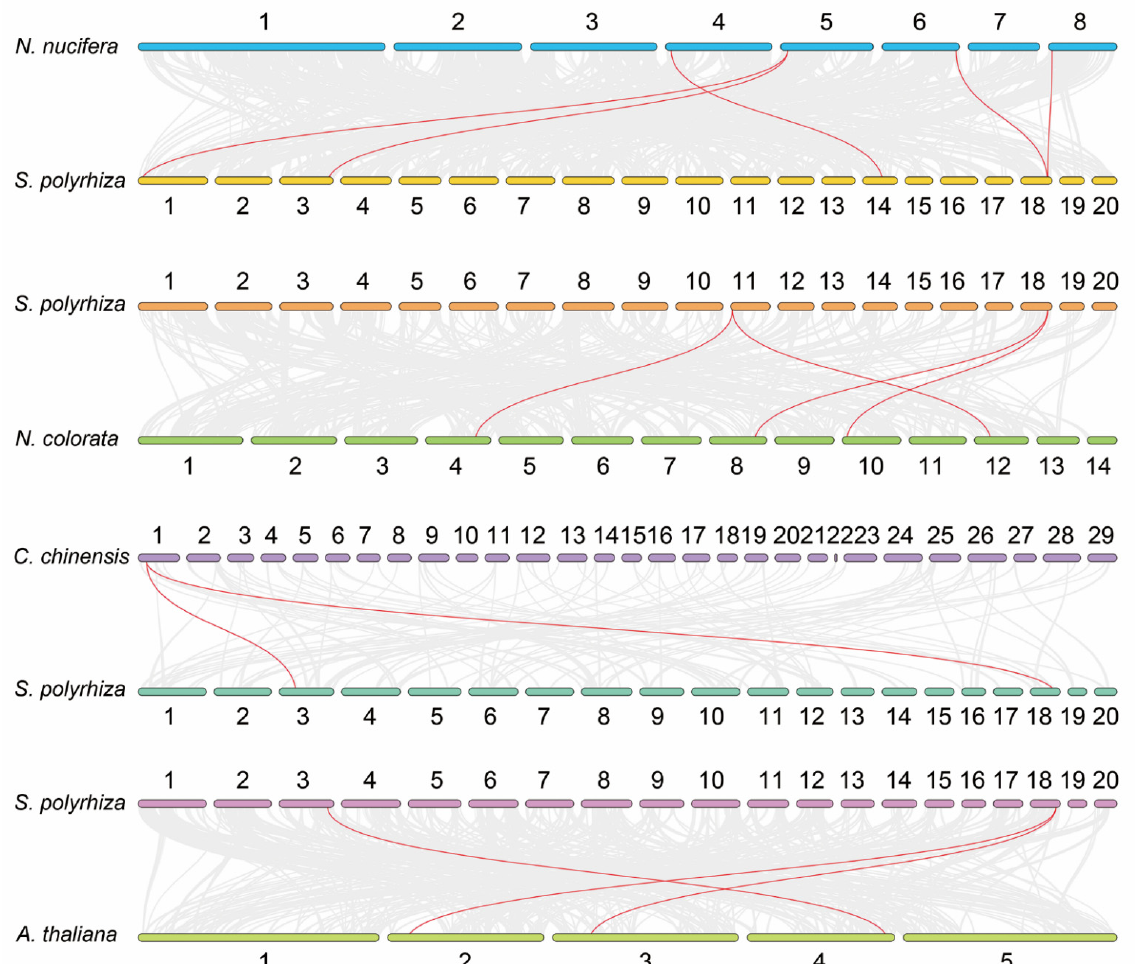
Figure 7. Synteny relationship of the GRF gene pairs between S. polyrhiza and four other plants. The red colour represents syntenic GRFs , and the gray lines show the collinear blocks of the plant ge- nome. The chromosome number was labeled near each chromosome.